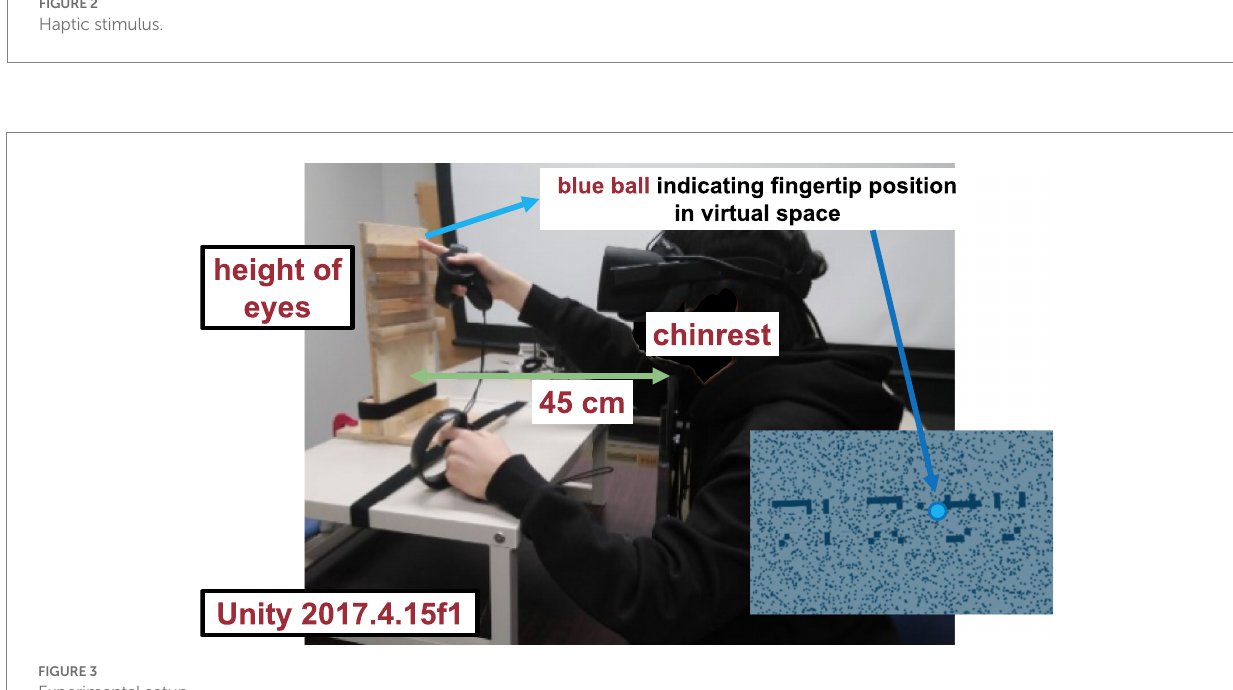
word was either in the background of the masking virtual ribbon that appeared to be an occlusion or in front of the virtual ribbon that appeared to be hollow. The visual cue was either present as a horizontal binocular disparity of the dots in the area covered by the virtual ribbon or absent by monocular presentation with a blank screen in the other eye. The haptic cue was either absent, consecutive, or concurrent. When the haptic cue was absent, the visual stimulus (i.e., the word and the virtual ribbon) was presented for 10 s, with the ribbon as an occlusion or a hollow, and with or without binocular disparity, followed by a uniform gray screen for another 10 s. The participant was instructed to report the recognized word verbally during the latter